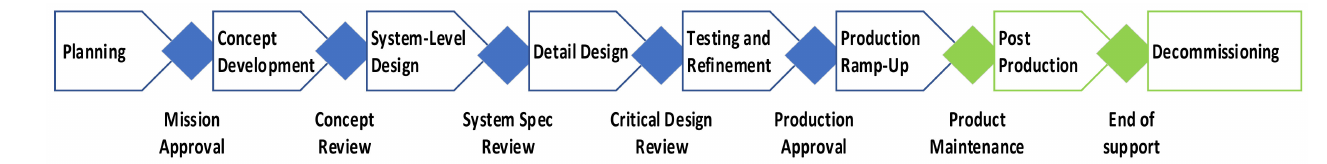
Figure 5. Updated project development process.